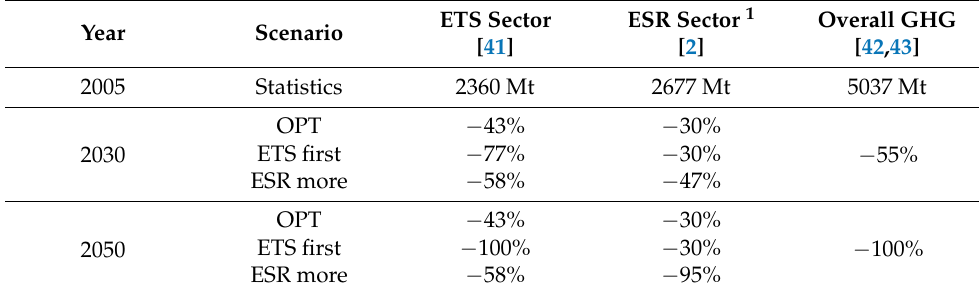
Table 1. GHG emission targets in the three scenarios. Emissions from waste and LULUCF are not